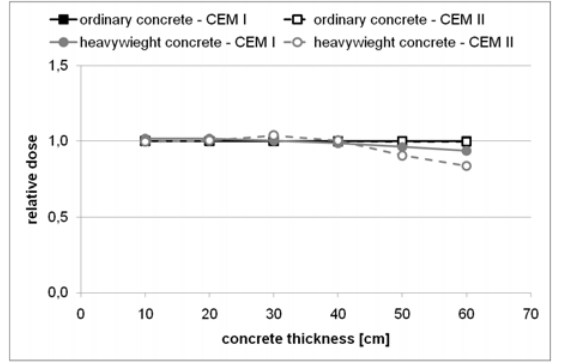
Figure 6. MCNPX simulations results for 1.0 MeV point source. Figure 4. SPOT simulations results for LWR neutron flux.